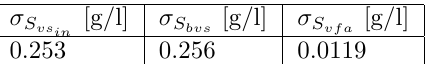
Table 7: Standard deviations of quantities which are varied (randomly) in bootstrapping with parametric simulation used to assess varia- tions of estimated